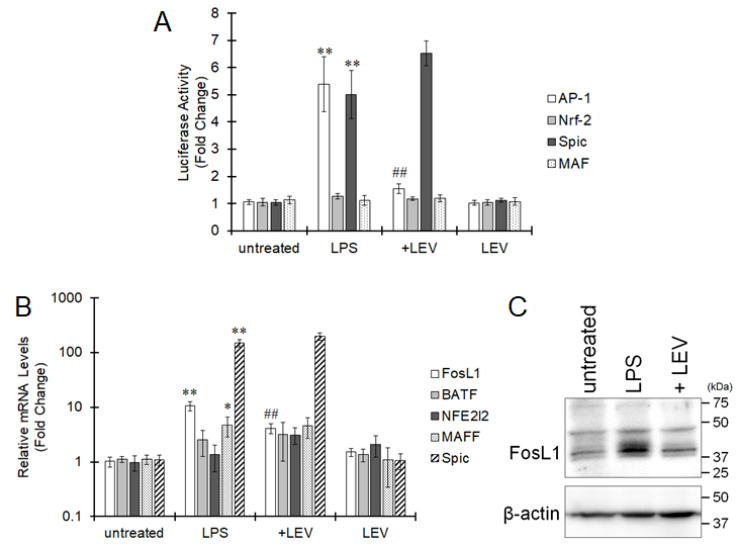
Figure 2. Attenuation of AP-1 activity and FosL1 expression by LEV. ( A ) Luciferase vectors were transfected into BV-2 cells with a ramified-like morphology. Cells were pretreated with LEV for 20 min and were then treated with LPS for 24 h. The cells were collected, and luciferase activity was measured. The values are presented as the mean ± S.E. of 5 separate experiments. The data were analyzed using ANOVA followed by Student (cid:48) s t -test. ** p < 0.01 vs. the untreated group and ## p < 0.01 vs. the LPS-treated group. B, C. BV-2 cells were pretreated with LEV for 20 min, and subsequently LPS was added for 24 h. ( B ) Total RNA was extracted, and mRNA expression was evaluated by real-time PCR. The values are presented as the mean ± S.E. of 5 separate experiments. The data were analyzed using ANOVA followed by Student (cid:48) s t -test. * p < 0.05 and ** p < 0.01 vs. the untreated group and ## p < 0.01 vs. the LPS-treated group. ( C ) Cells were collected, followed by Western blotting to assess FosL1 expression. A representative image from 3 experiments is